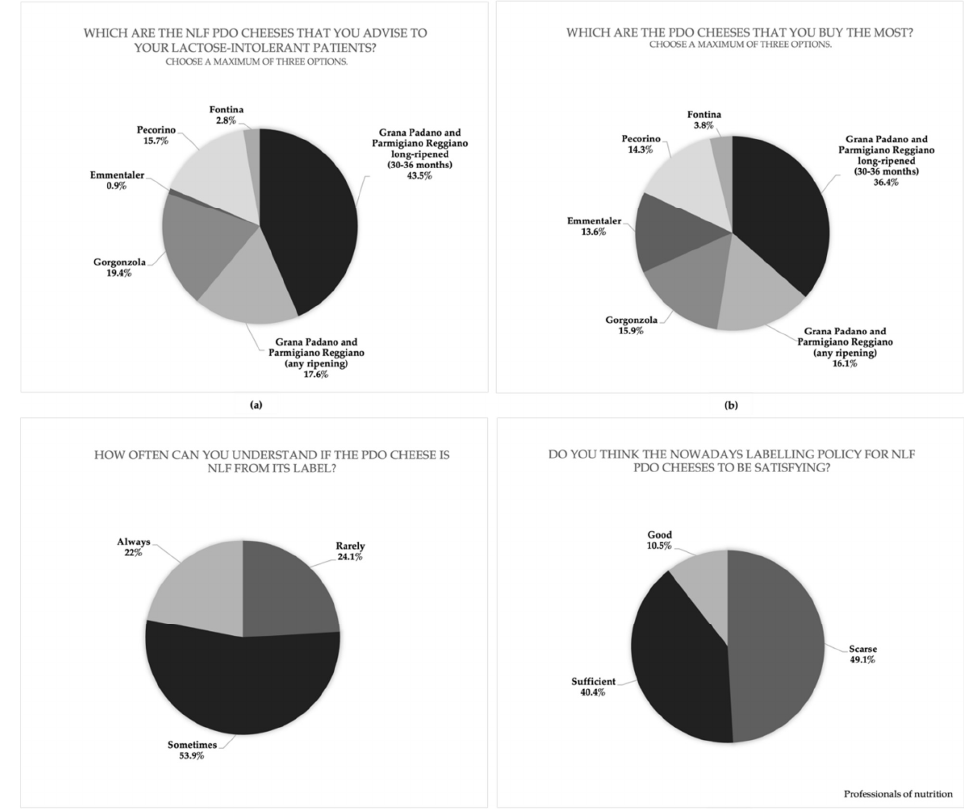
Figure 2. Outcomes of the questionnaires administered to professionals of nutrition and consumers with LI. (a) PDO cheeses recommended by professionals of nutrition to their patients with LI. (b) PDO cheeses mainly purchased by consumers with LI. (c) Understanding of the PDO cheeses’ labels by consumers with LI. (d) Satisfaction of the PDO cheeses’ labelling policy by professionals of nutrition.